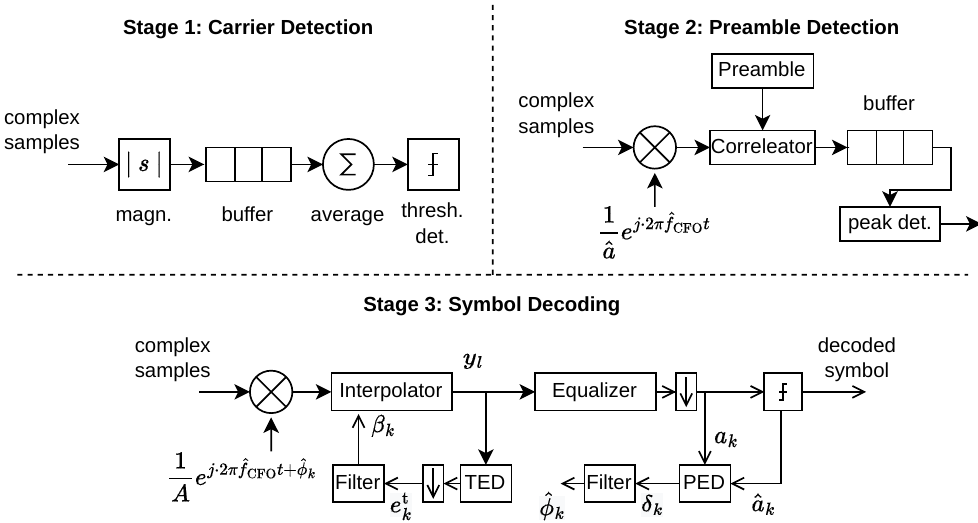
Figure 8. The SDR pipeline has three stages: Carrier detection, preamble detection, and symbol decoding. CFO ˆ f CFO , phase error ˆ φ , and TE β must be estimated and tracked throughout the